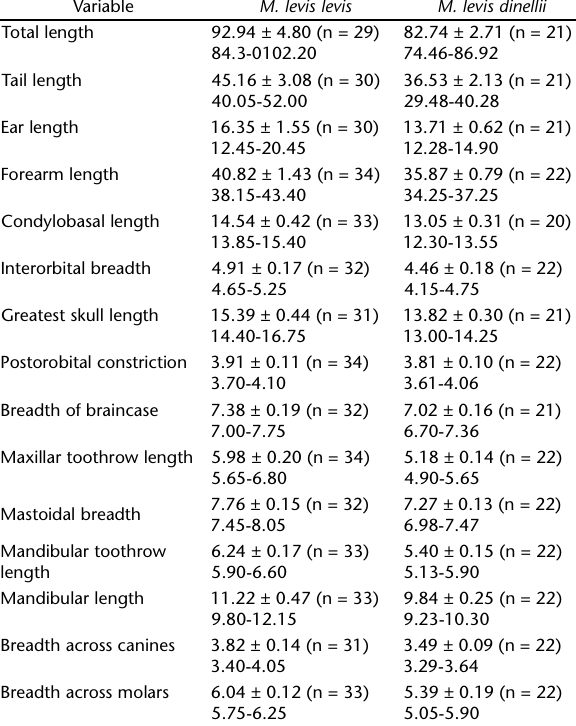
Table III. Loadings of 15 log-transformed morphometric traits and principal components (PC1, PC2, and PC3) for Myotis levis levis and Myotis levis dinellii , Myotis albescens , Myotis ruber , Myotis riparius , and Myotis nigricans samples.